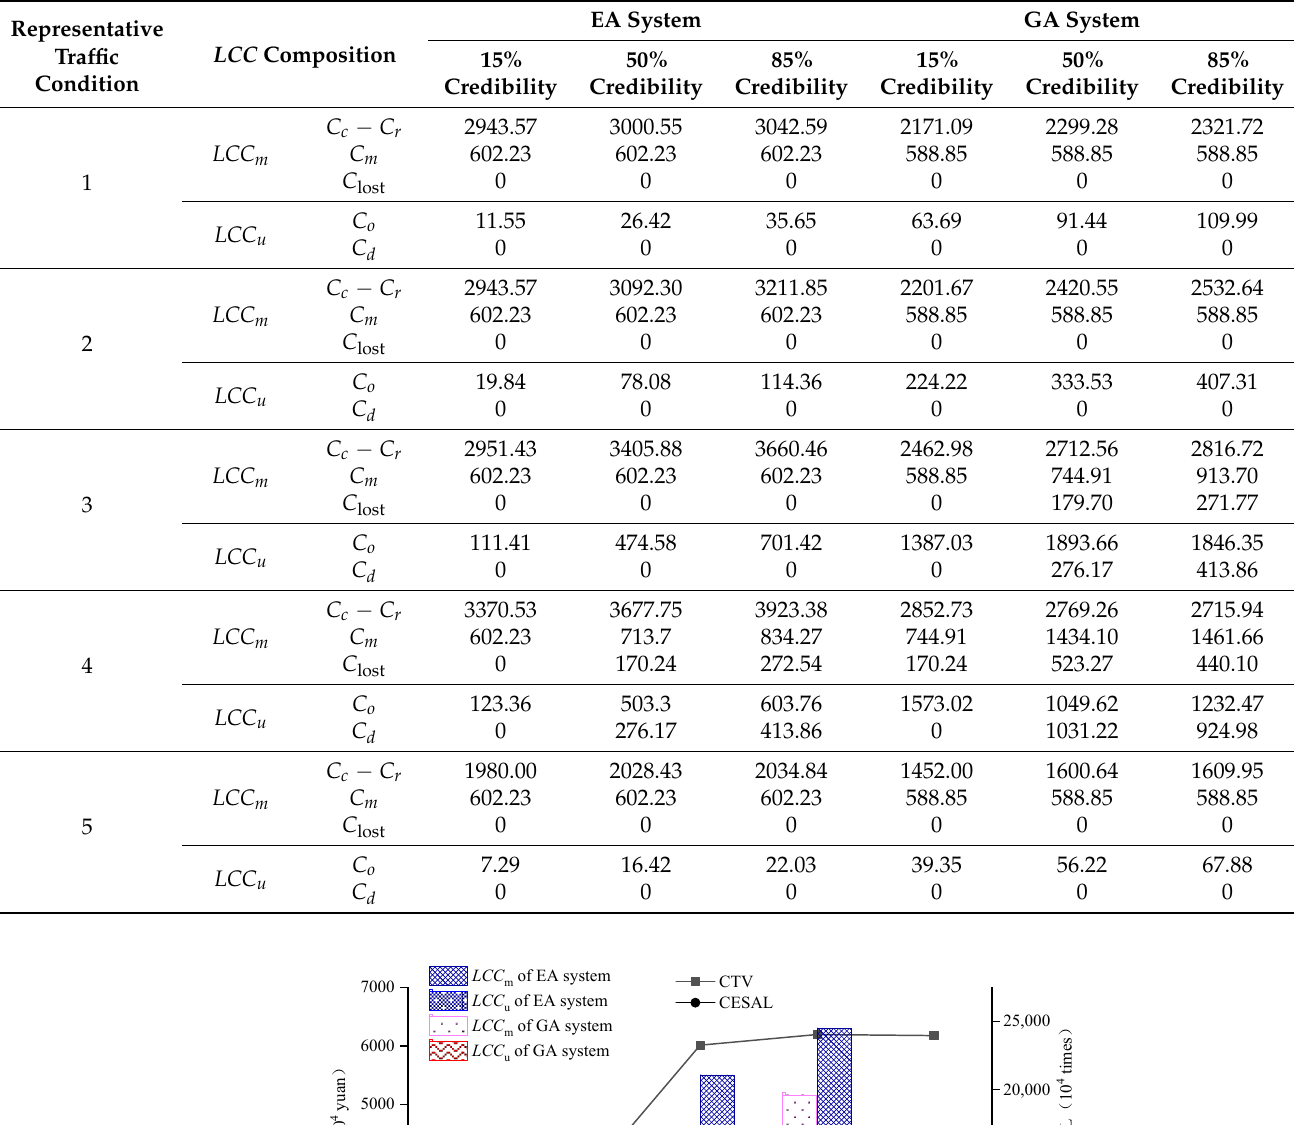
Table 6. The LCC composition of SBDPS under representative traffic conditions (unit: 10 4 yuan).